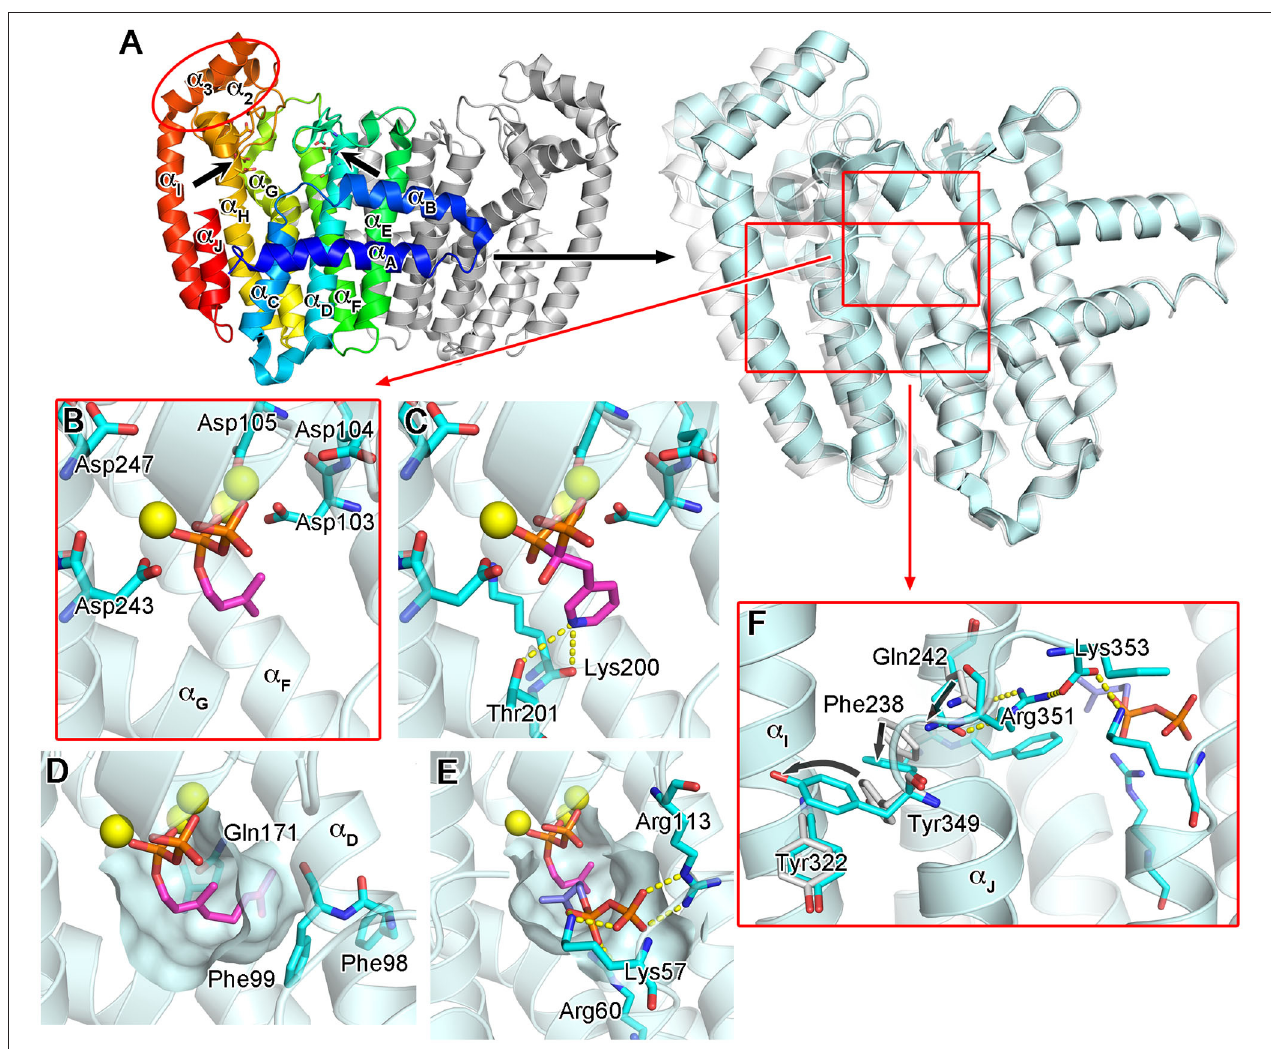
FIGURE 3 | Overall structure and substrate/N-BP binding of human FPPS. (A) The overall structure of hFPPS. Left side: the homodimeric biological assembly in the unliganded open conformational state [Protein Data Bank (PDB) ID: 2F7M]. One subunit is represented in a rainbow color scheme (blue to red from the N- to C-terminus). The locations of the conserved aspartic acid-rich motifs are indicated by arrows. Right side: superimposed structures of hFPPS in the open (semi-transparent white; PDB ID: 2F7M) and fully closed (cyan; PDB ID: 4H5E) states. For clarity, only one subunit is displayed. (B) DMAPP (magenta) bound to the active site of hFPPS. The residues of the DDXXD motifs are in stick representation. Mg 2 + ions are shown as yellow spheres. DMAPP was modeled into the PDB structure 4H5E based on an analog-bound E. coli FPPS structure (PDB ID: 1RQI). (C) The binding of risedronic acid (PDB ID: 1YV5). Yellow dashes indicate a bifurcated H-bond. (D) The hydrophobic pocket of the allylic substrate site in semi-transparent surface representation. Displayed in magenta is a modeled GPP molecule. (E) The IPP sub-pocket in the enzyme-substrates ternary complex (DMAPP in magenta and IPP in light purple). (F) The conformational cascade required for the C-terminal tail